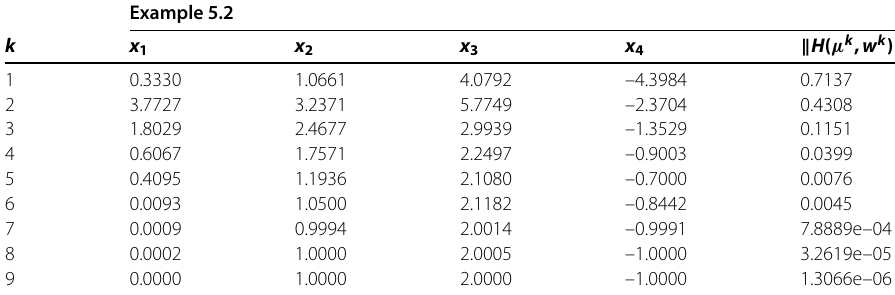
Table 2 Numerical results for Example 5.2 with x 0 = (0,0,0,0) Example 5.2